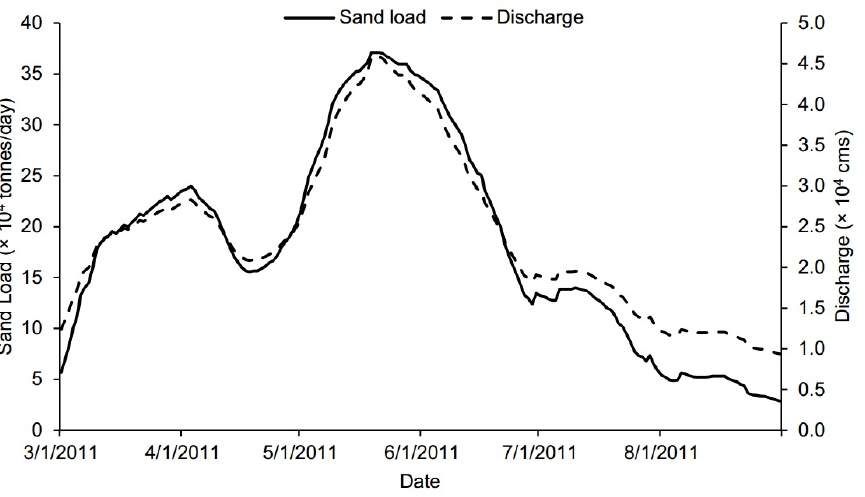
Figure 6. River discharge (cms) and estimated daily sand load (tonnes/day) at Tarbert Landing pre and post the 2011 Mississippi River spring